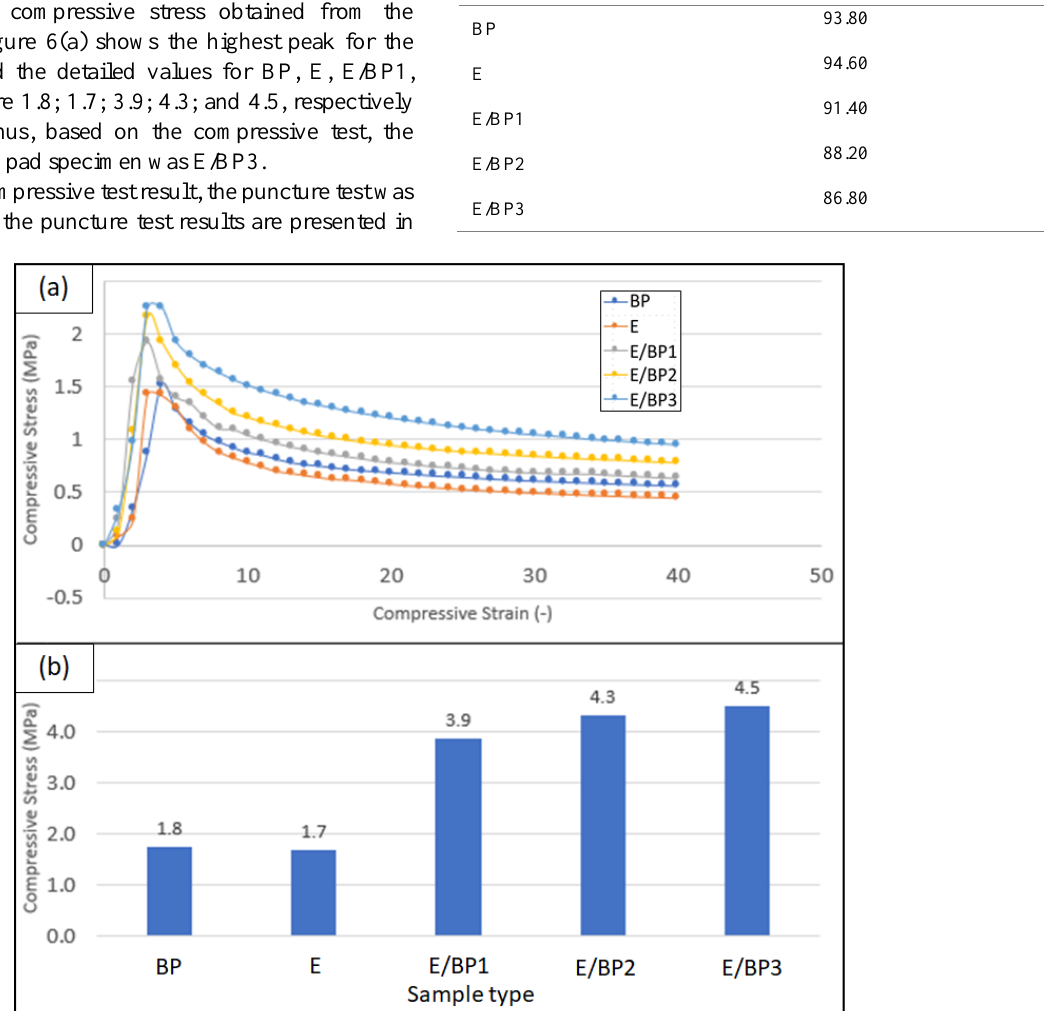
Fig. 6. The compressive test results: (a) compressive stress-strain curves; and (b) compressive strength